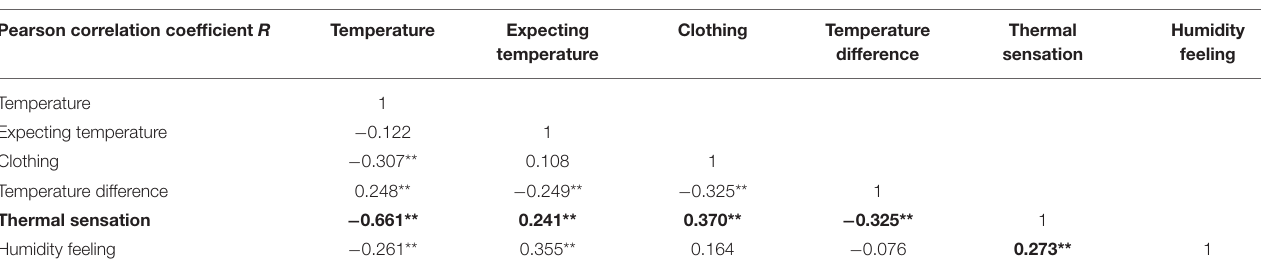
TABLE 7 | Correlation analysis of variables in winter.